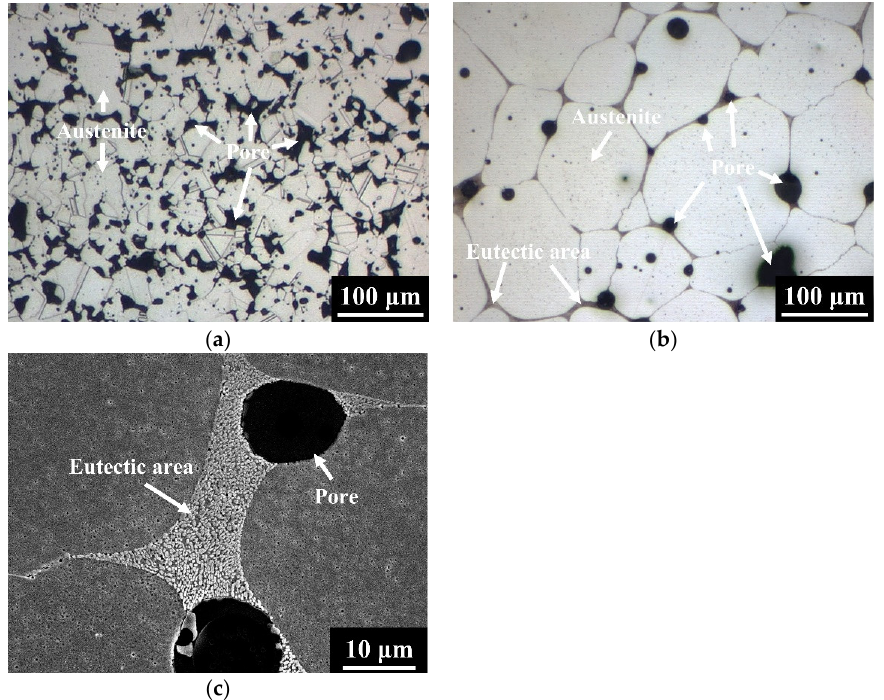
Figure 3. Microstructures of the ( a ) 304L and ( b ) 304L + 0.6B PM stainless steels. ( c ) High magnification of a eutectic area in 304L + 0.6B.